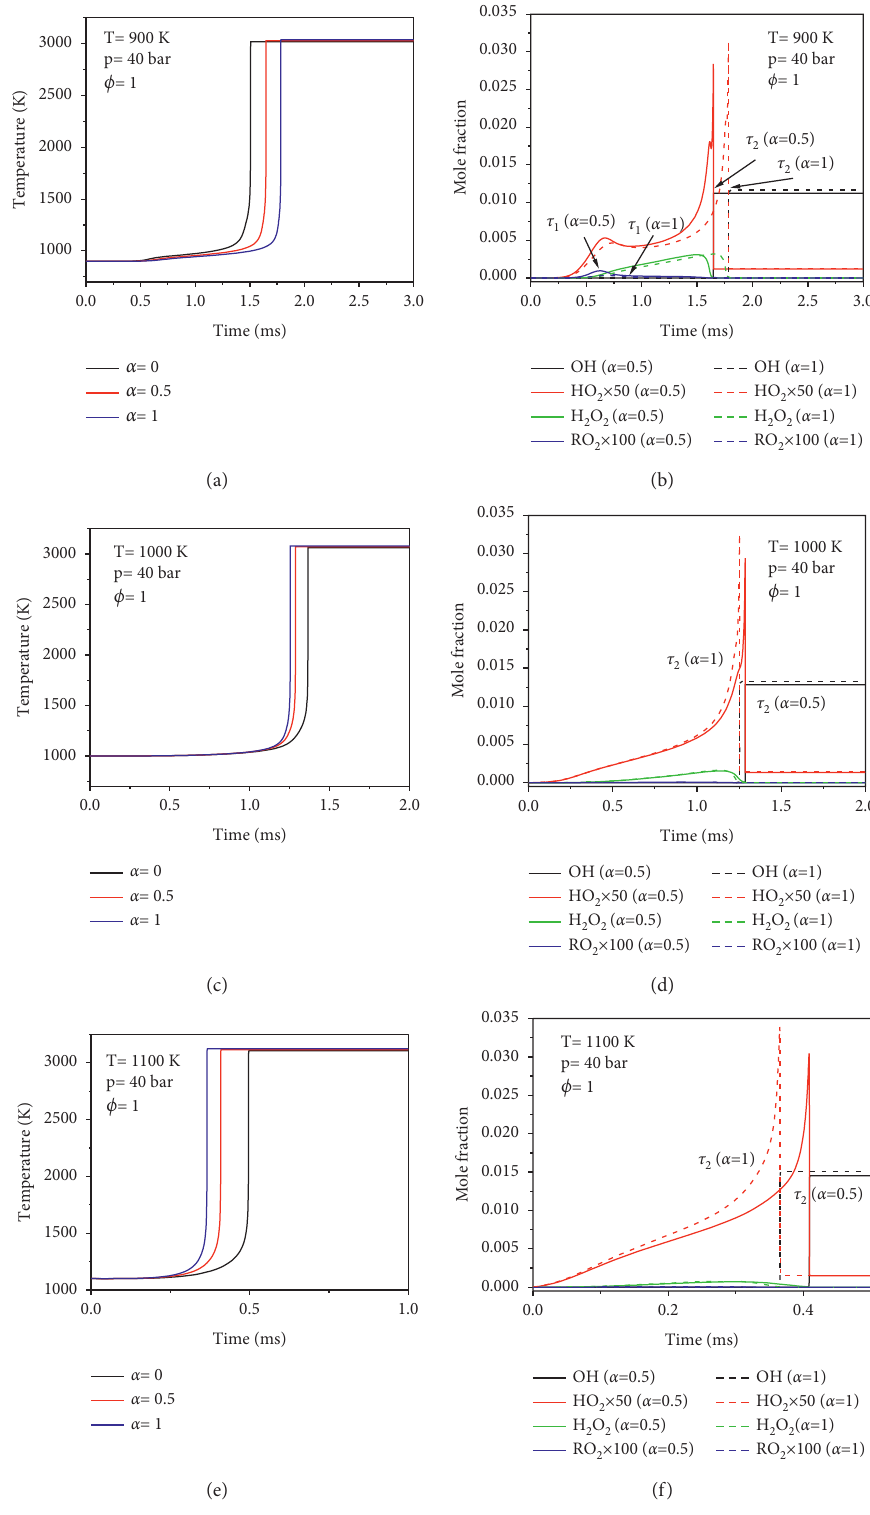
Figure 8: Effect of initial temperature and α on temperature and intermediate radical mole fraction evolution for methane/H mixtures at β � 4.545 × 10 − 2 , p � 40 bar, and ϕ �